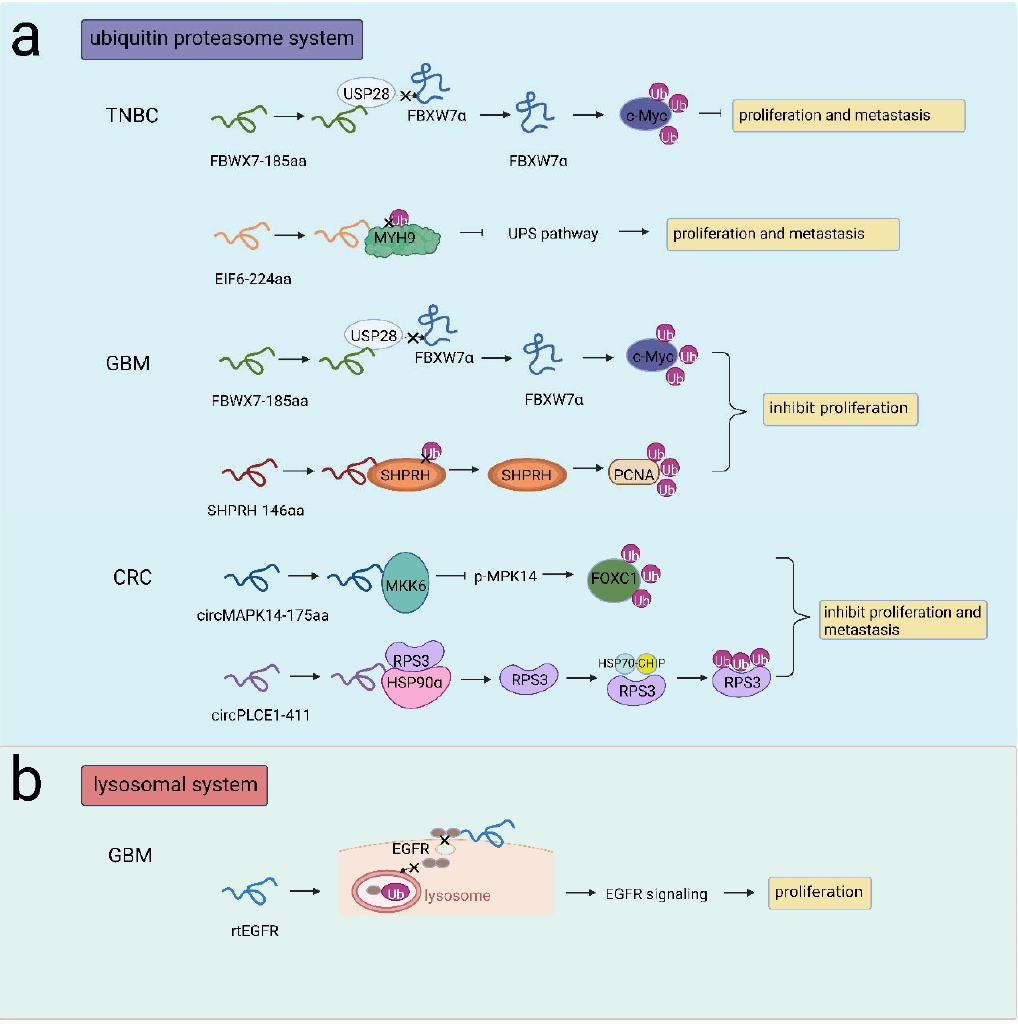
Figure 4. NcRNA ‐ encoded peptides/proteins regulated protein stability . ( a ) FBXW7 ‐ 185aa compet